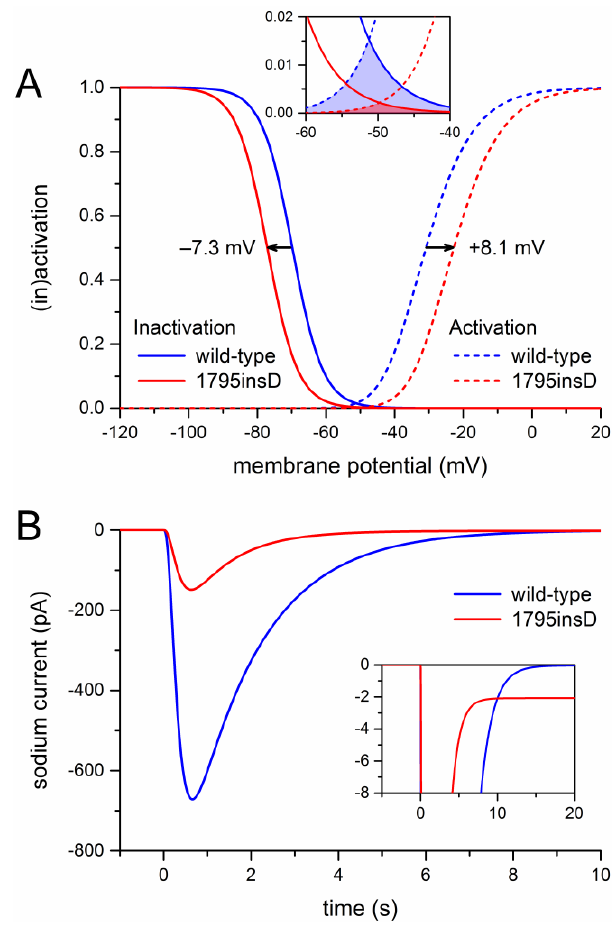
Figure 1. Incorporation of the effects of the 1795insD mutation observed in expression systems into the Fabbri – Severi model of a human SA nodal pacemaker cell. ( A ) Mutation-induced shifts of +8.1 and −7.3 mV, as indicated by horizontal arrows, in the steady-state I Na activation and inactivation curves of the Fabbri – Severi model cell. The inset shows the effects of the shifts on the I Na window current. ( B ) Current traces of the wild-type and the 1795insD mutant I Na upon a simulated voltage clamp step from a holding potential of −100 mV to a test potential of −25 mV. The inset shows the persistent component of the mutant I Na .